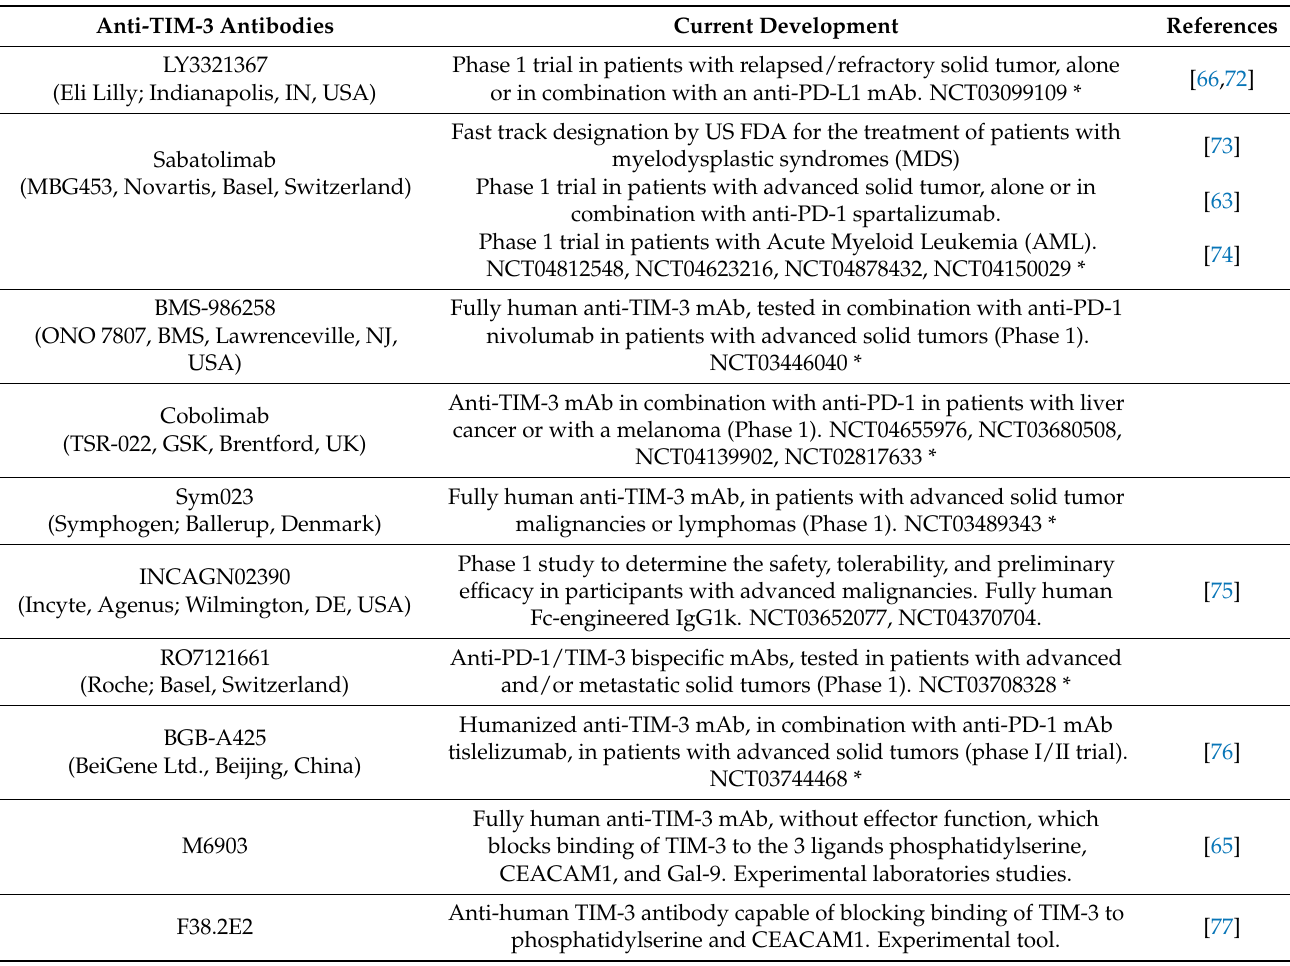
Table 1. Human anti-TIM-3 antibodies in